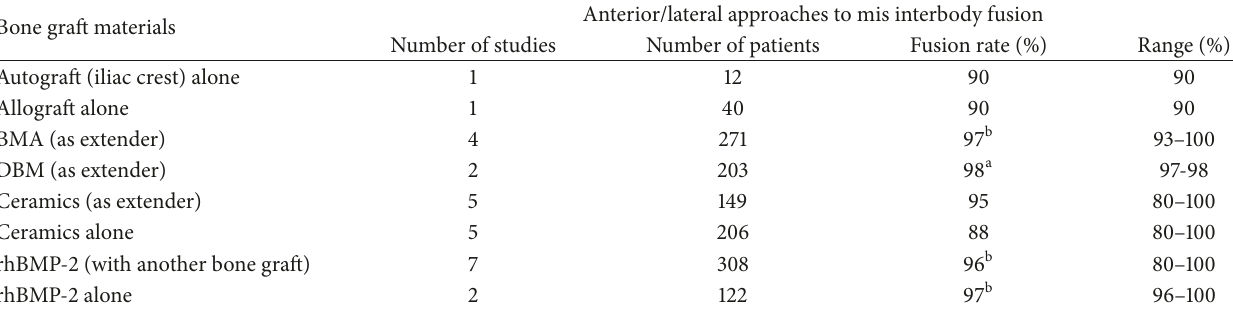
Table 2: Fusion rates for various bone grafts in anterior/lateral approaches to minimally invasive interbody fusions. Bone graft